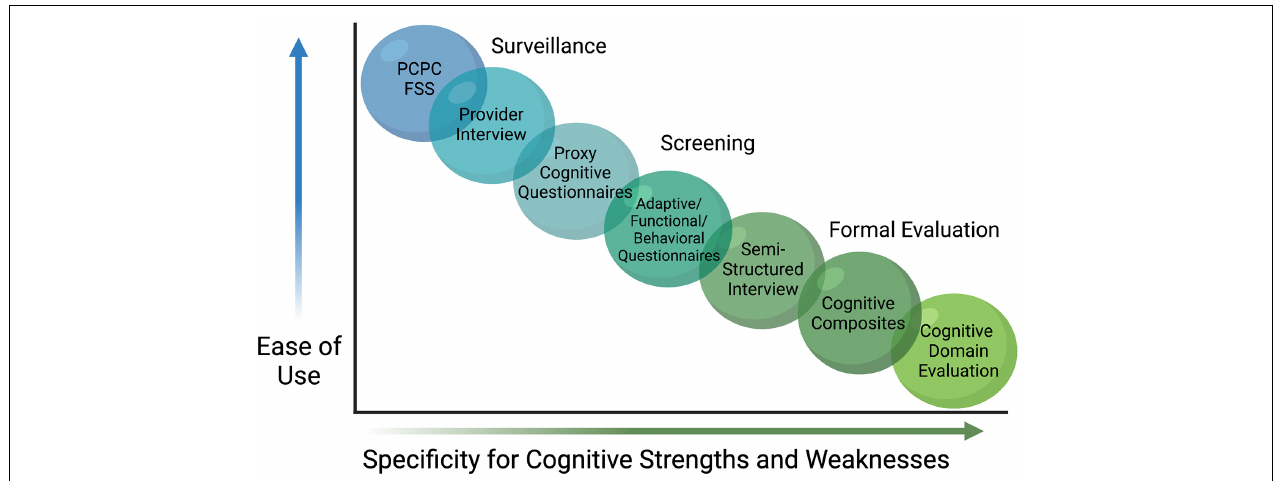
FIGURE 1 | Continuum of Cognitive Assessments. A variety of assessment tools and approaches exist for evaluating cognitive dysfunction after discharge from pediatric intensive care. While some are useful for surveillance or screening, they are less specific for many aspects of cognitive function, particularly cognitive domains. Within the limitations of each strategy, investigators can select an approach that best addresses their aims. Pediatric Cerebral Performance Category (PCPC), Functional Status Scale